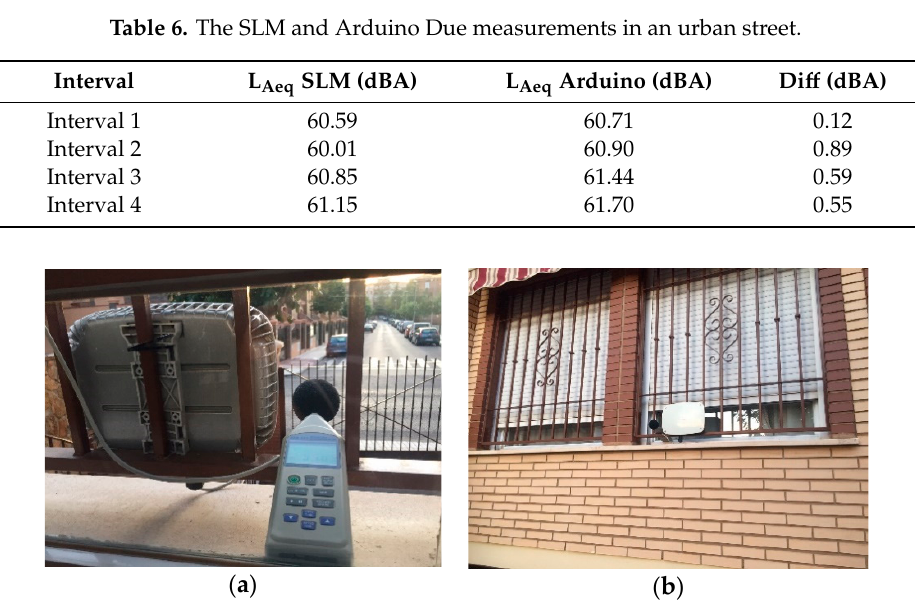
Table 6. The SLM and Arduino Due measurements in an urban street.